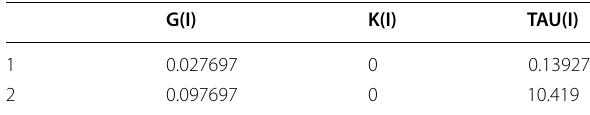
Table 1 Number of nodes and elements of the FE models Configuration